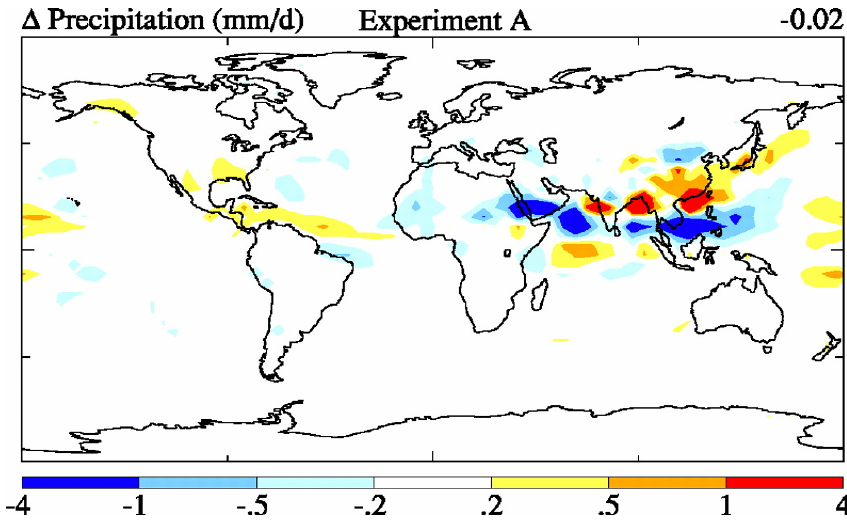
Fig. 40. Simulated JJA surface precipitation changes for an experiment including a mixture of sulfate and BC, yielding absorbing aerosol particles with ssa=0.85, minus a reference simulation without aerosol forcing (from Menon et al., 2002, copyright 2002 by the American Association for the Advancement of Science, reproduced with